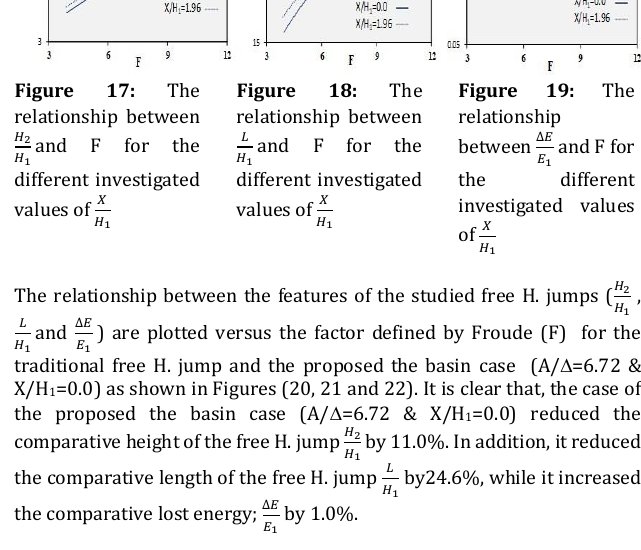
Figure 28: The relationship between the residuals’ values versus the statistical training comparative lost energy over the free H. jump Eq.